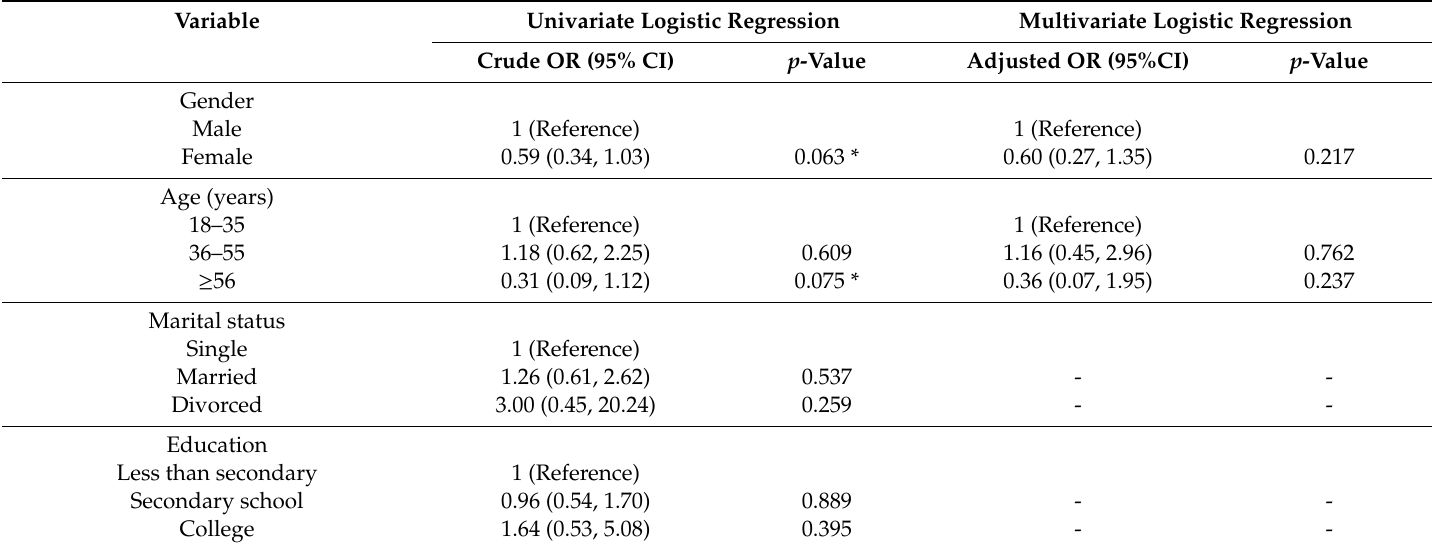
Table 5. Univariate and multivariate logistic regression for variables associated with post-traumatic stress disorder